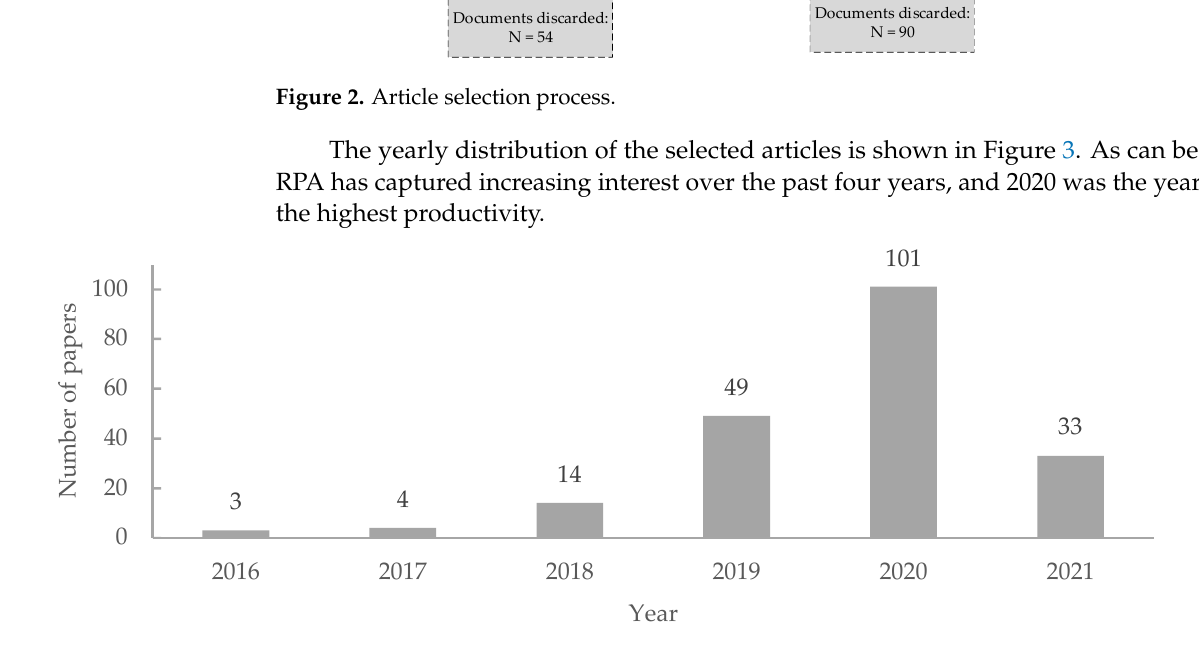
Figure 3. Yearly distribution of papers published with RPA applications.